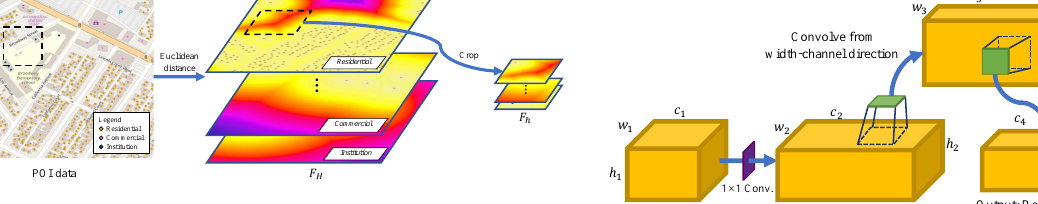
Figure 2. An example of building heatmap tensor according to Euclidean distance. Figure 3. Architecture of CAM. There are three convolutional layers in a CAM. A convolutional layer with size of one is for dimensionality increase, and two layers for extract feature from channel